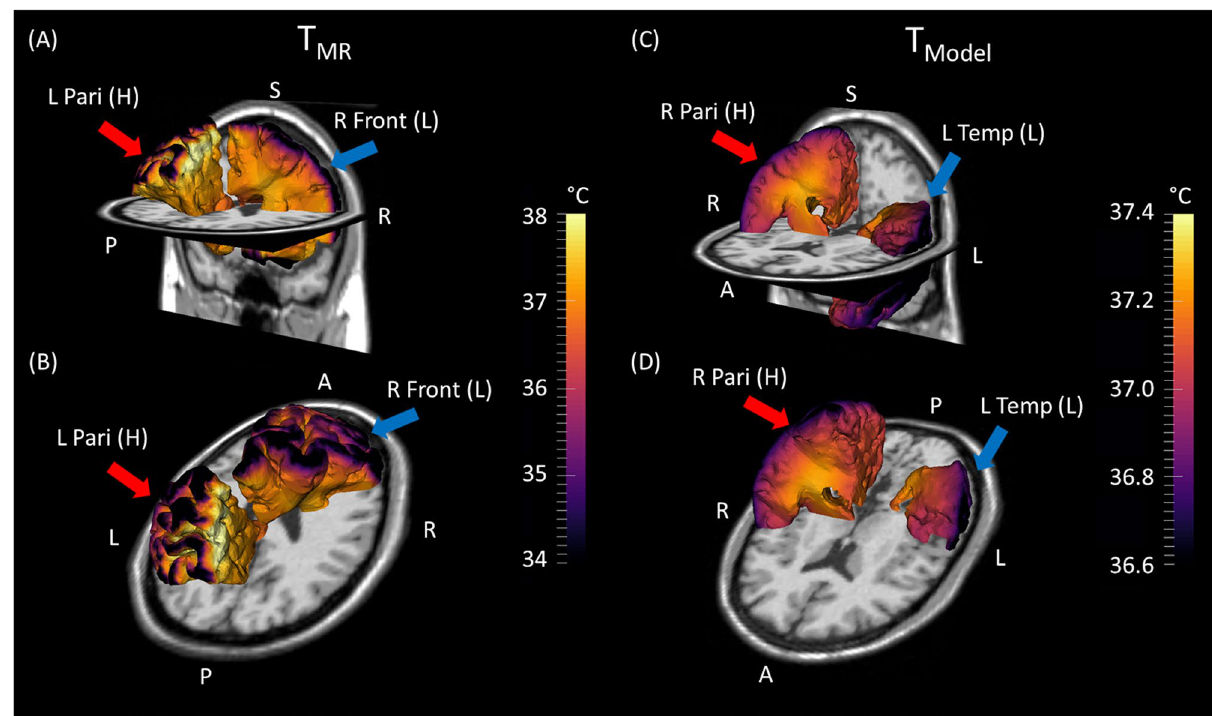
Figure 5. Lobar-scale 3D images overlaid with ( A,B ) MR-measured and ( C,D ) model-predicted brain temperature maps. Lobes with the highest average temperature (i.e., left parietal lobe [T MR ] and right parietal lobe [T Model ]) are highlighted with red arrows. Lobes with the lowest average temperature (i.e., right frontal lobe [T MR ] and left temporal lobe [T Model ]) are highlighted with blue arrows. MR-measured temperatures range from [34.0 °C, 38.0 °C], while model-predicted temperatures range from [36.6 °C, 37.4 °C]. T MR MR-measured temperature, T Model model-predicted temperature, L left, R right, Pari parietal lobe, Front frontal lobe, Temp temporal lobe, (H) highest temperature lobe, (L) lowest temperature